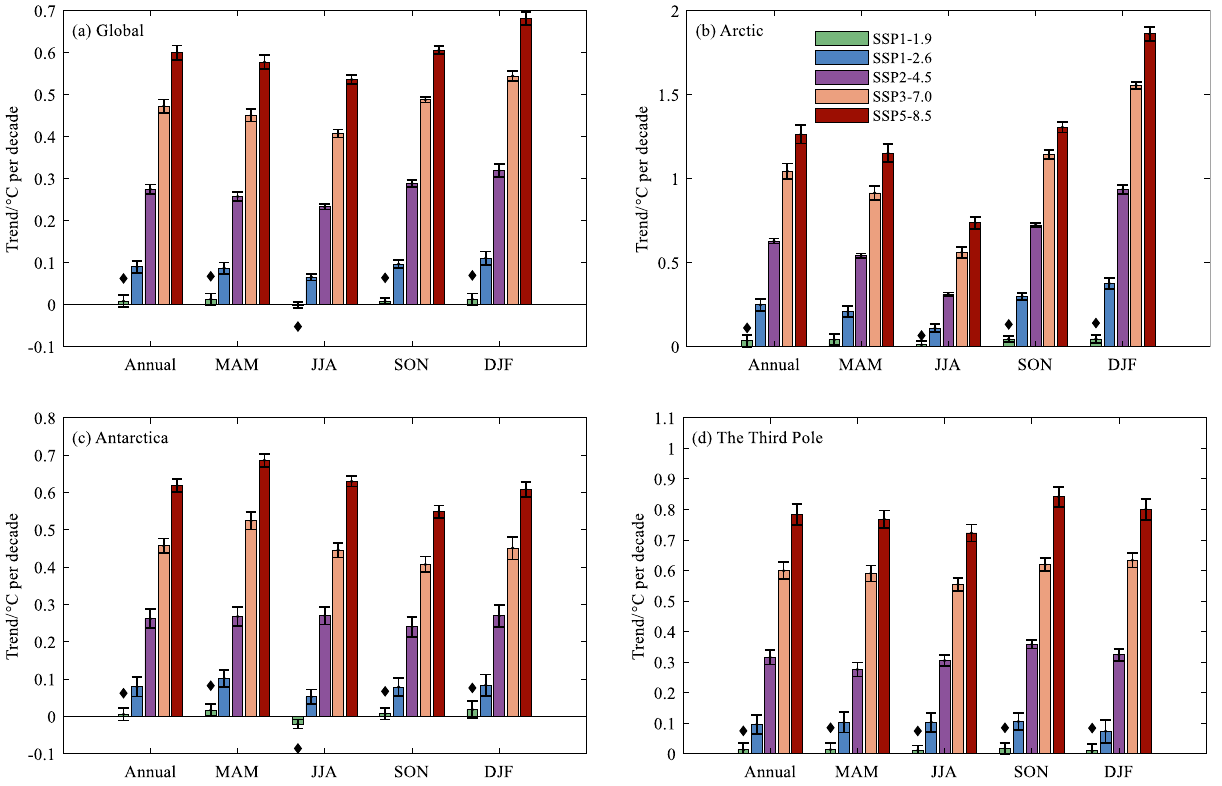
Figure 6. Similar to Fig. 4, but for regional average trends (°C per decade) during 2015–2100. The black rhombus symbol ♦ represents that the trend is not significant. The others are significant at the 95% confidence